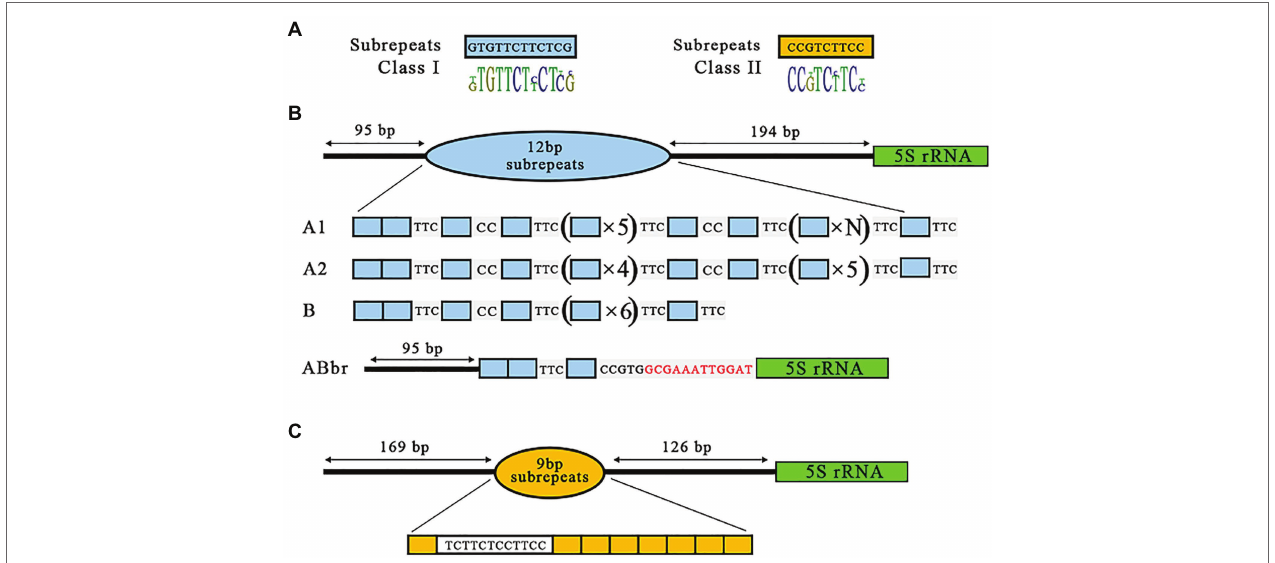
FIGURE 3 | Diversity of 5S rDNA NTS repeats in the gene of Landoltia punctata NB0014. (A) The NB0014 5S rDNA NTS repeats are classified into class I and class II, based on the type, number, and arrangement of their 12-bp (blue blocks) or 9-bp (yellow blocks) subrepeats in relation to the 5S rDNA gene (marked by green; B ). Class I is further divided into four subclasses: A1, A2, B, and ABbr. Red letters in the ABbr variant indicate the 12 nucleotides upstream of the 5S rDNA gene that are shared by all NTS class I sequences (C) . Class II is represented by a single NTS type of 9-bp